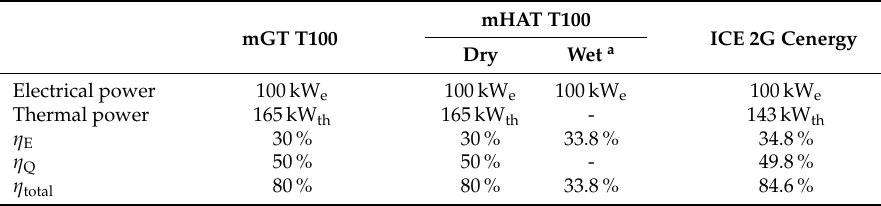
Table 2. Main technical characteristics of the three